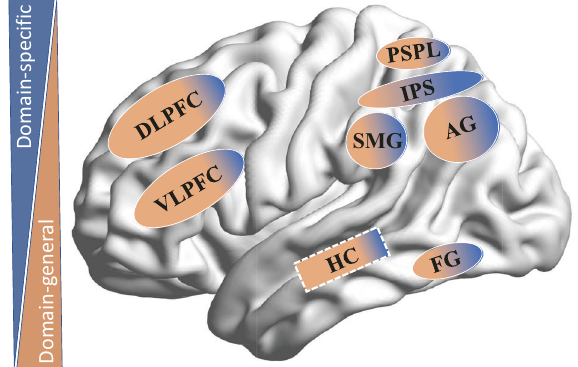
Fig. 3 Brain regions of the arithmetic network. The blue and orange color coding indicates the relative domain-speci fi c and domain-general involvement of the particular brain regions. DLPFC dorsolateral prefrontal cortex, VLPFC ventrolateral prefrontal cortex, PSPL posterior superior parietal lobe, IPS intraparietal sulcus, SMG supramarginal gyrus, AG angular gyrus, FG fusiform gyrus, HC hippocampus (the dotted lines indicate the medial position of this brain